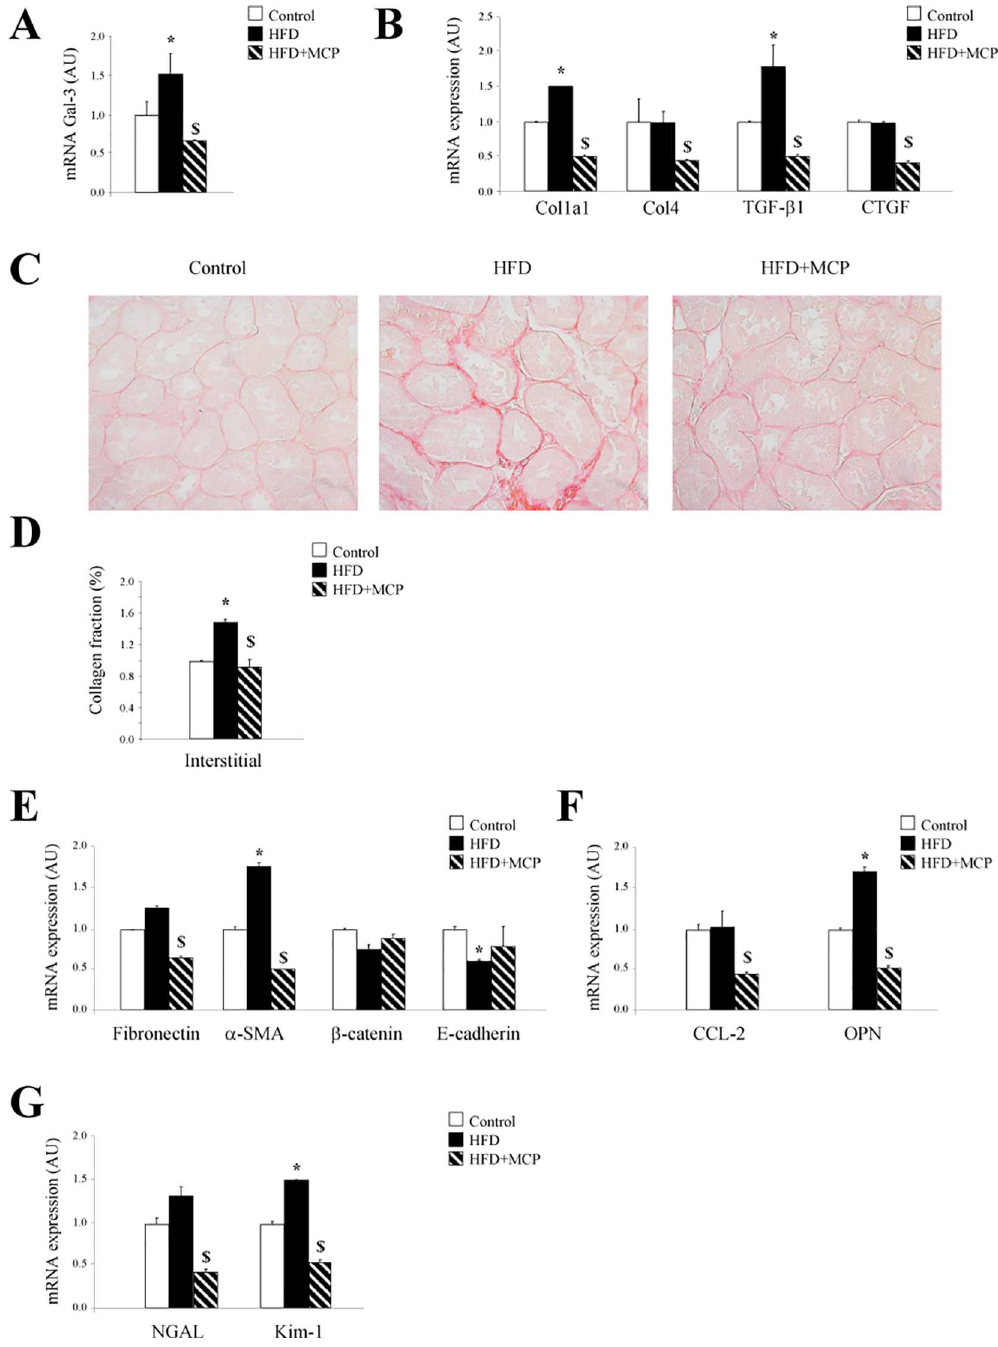
Fig 1. Effects of pharmacological inhibition of Gal-3 on renal damage in obese rats. Expression of mRNA of Gal-3 (A) . Quantification of fibrotic markers expression( B ). Representative microphotographs of renal sections stainedwith Sirius red ( C ). Quantification of tubulointerstitial fibrosis ( D ). Expression of epithelial-mesenchymal transition molecules( E ). Expression of inflammatory mediators (F) . Expression of kidney damage markers (G) . Magnification of the microphotographs 40x. Histogram bars represent the mean ± SEM of each group of animals (n (cid:21) 7 per group) in arbitrary units or as a percentageof stainingnormalized to HPRT and β -actinfor cDNA. * p < 0.05vs. control group; $ p < 0.05vs HFD